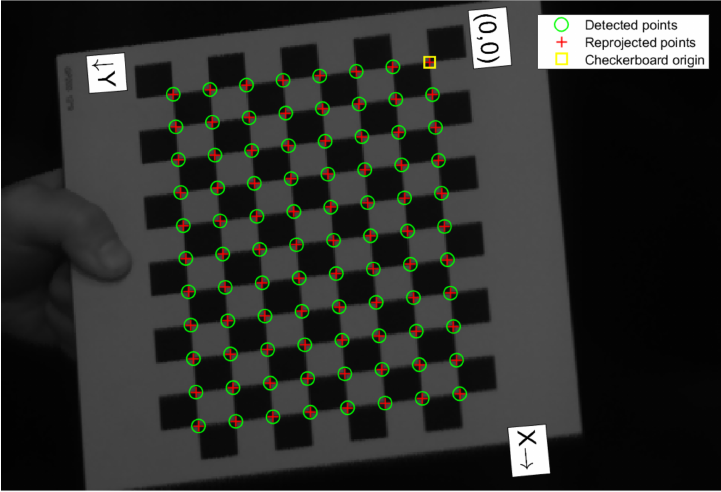
Figure 11. Example of location of identified corners and reprojected corners on the